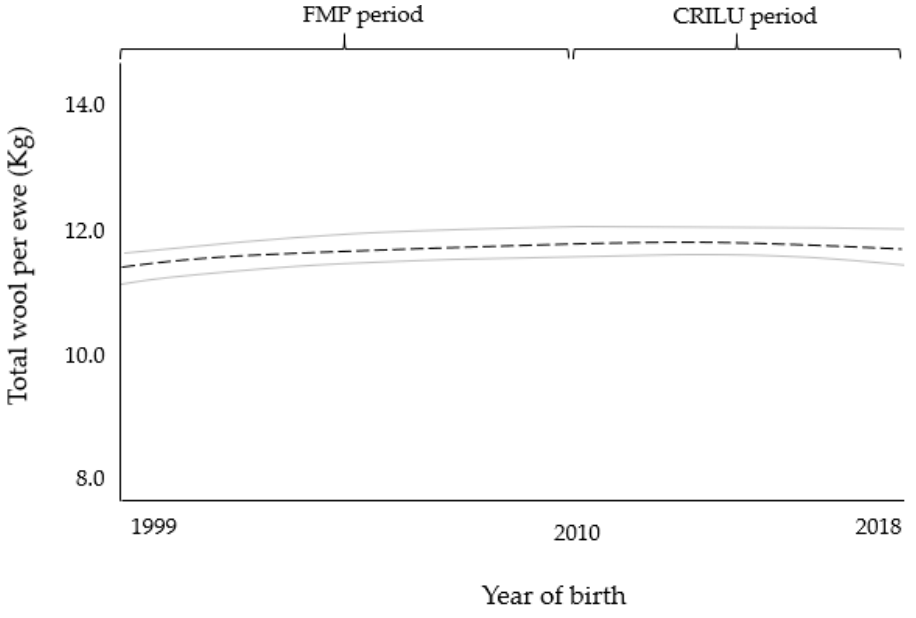
Figure 5. Mixed-age ewe phenotype trend for the accumulative total lamb live weight at weaning across all lambing opportunities (1–8) per year of birth (1999–2018) using a second-degree polynomial regression. Lambing opportunities correspond to the number of mating seasons each ewe had over her lifetime.